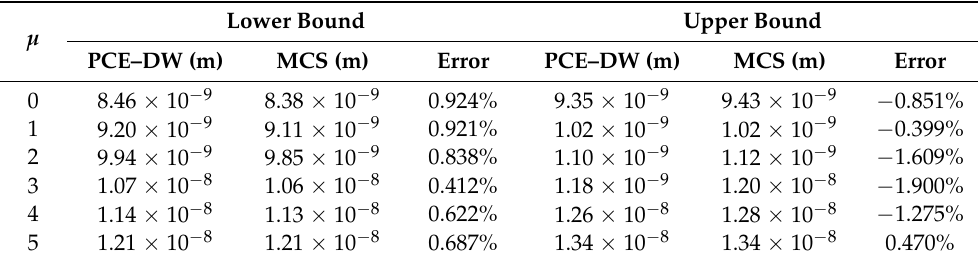
Table 7. The bounds of the expectation calculated by PCE–DW and MCS.